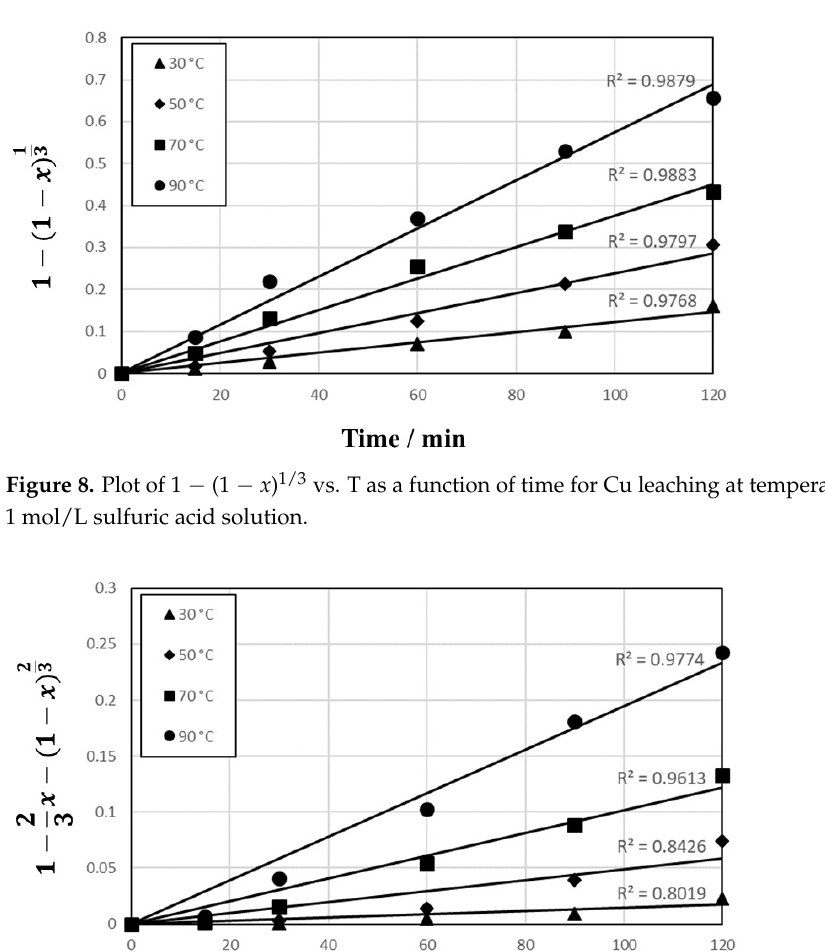
Figure 11. Arrhenius plot for Cu leaching in 1 mol/L sulfuric acid solution. 4. Conclusions Mild leaching conditions using Cu 2+ and O 2 in sulfuric acid solution were investi- gated to leach Cu from PCBs. When Cu 2+ and O 2 were added to the leach solution, the leaching efficiency of Cu increased faster than that of the leaching test performed without Cu 2+ and O 2 . On the other hand, the simultaneous use of Cu 2+ and O 2 improved Cu leach- ing from PCBs. The leaching efficiency of Cu increased with the increasing agitation speed, temperature, gas flow rate of O 2 , and initial Cu 2+ concentration and decreasing pulp density. The leaching efficiency of Cu increased to 96% in 1 mol/L sulfuric acid solution at temperature 90 °C, agitation speed 600 rpm, pulp density 1%, Cu 2+ concentration 10,000 mg/L, and O 2 introduction flow rate 1000 cc/min. The kinetic data indicate that the leach- ing behavior of Cu followed the reaction-controlled model well rather than the diffusion- controlled model, and the activation energy was calculated to be 23.8 kJ/mol, which is similar to the data reported in the conventional studies. Therefore, these results suggest that the sulfuric acid solution with Cu 2+ and O 2 addition will be a suitable leaching condi- tion to leach Cu from PCBs. Author Contributions: Methodology, Y.P. and K.Y.; writing—original draft preparation, Y.P. and K.Y.; data curation, Y.P.,Y.E., and K.Y.; writing—review and editing, K.Y. and M.K.J.; providing ideas, Y.P. and K.Y. All authors have read and agreed to the published version of the manuscript. Funding: This work was supported by the Technology Innovation Program (or Industrial Strategic Technology Development Program—Development of Material Component Technology) (20011176, Development of Advanced Technology in Hydrometallurgy for High Added Value of Resources Recovery) Funded by the Ministry of Trade, Industry, and Energy (MOTIE, Korea). Data Availability Statement: Not applicable.